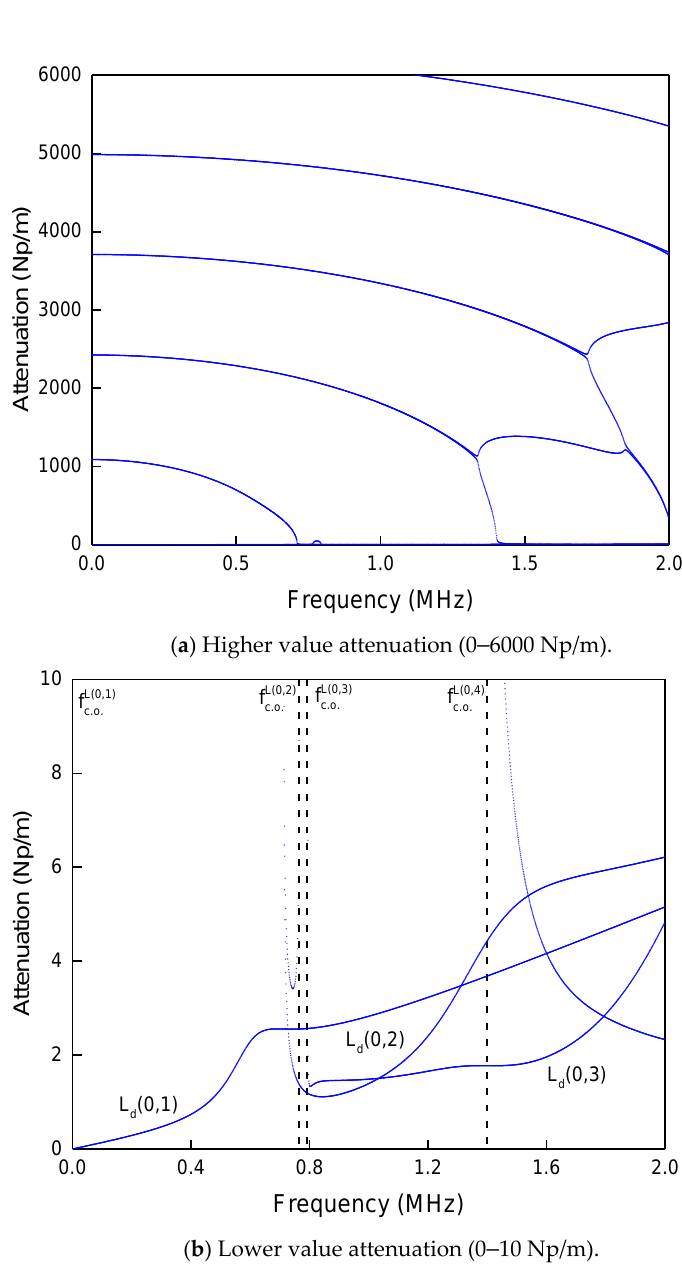
Figure 4. Attenuation curve: ( a ) Higher value attenuation (0 – 6000 Np/m); ( b ) lower value attenuation (0 – 10 Np/m).